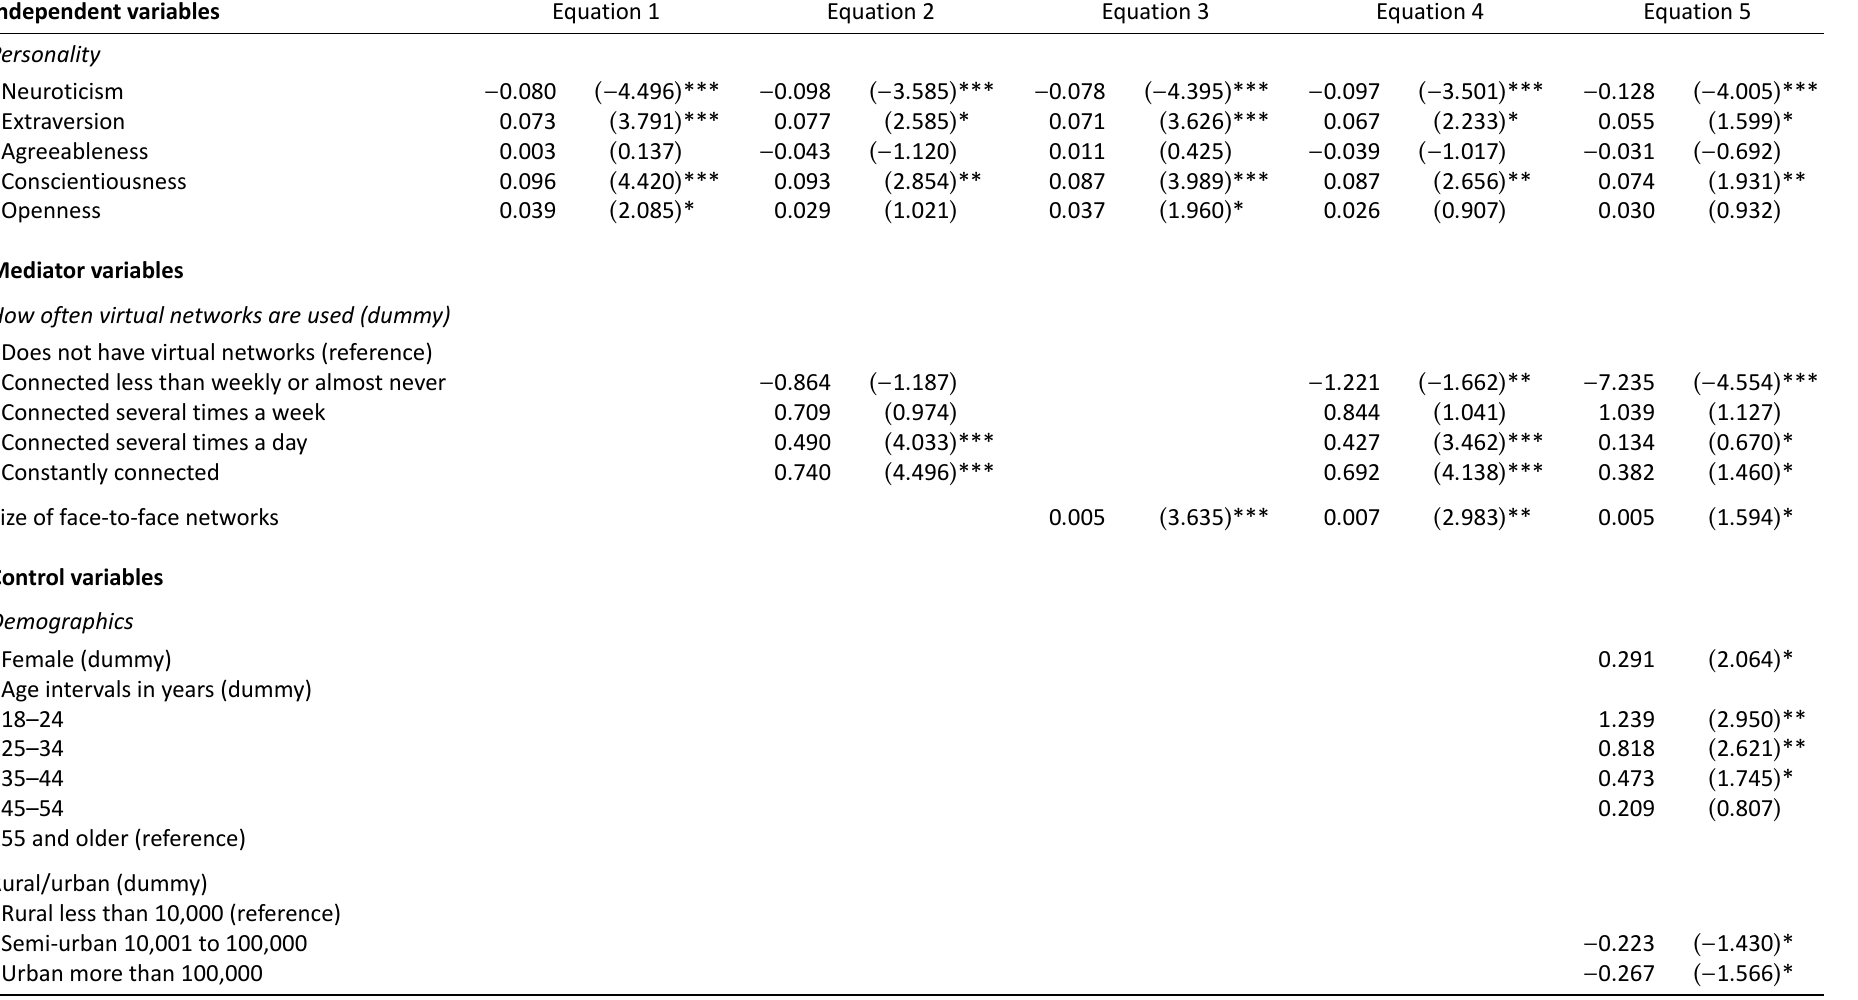
Table 4. Impact of personality trails and social media on subjective well‐being, OLS regression